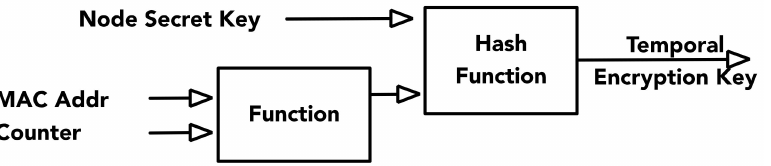
Figure 6. Temporal encryption key generation using a symmetric encryption algorithm (i.e.,